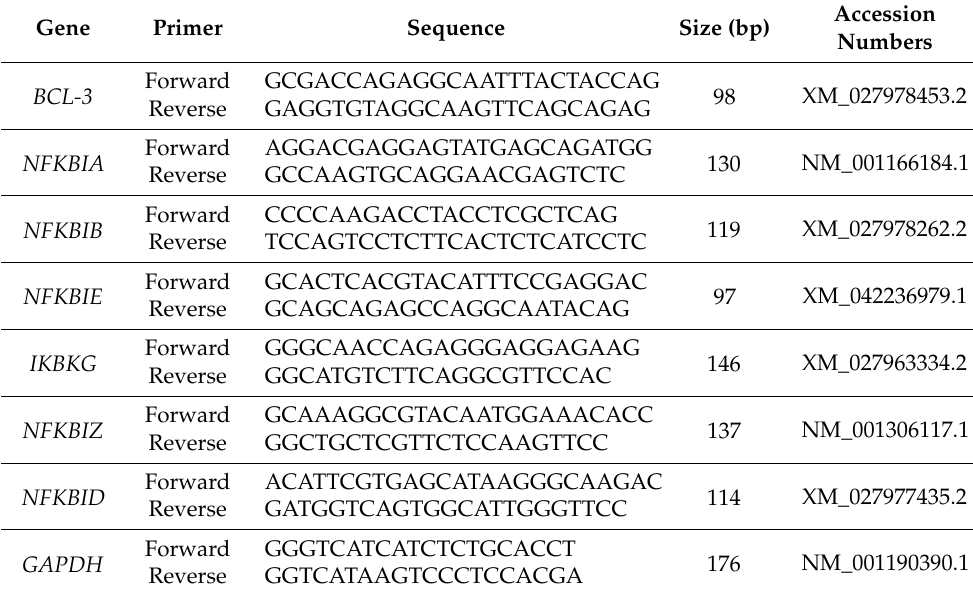
Table 1. Primers used for